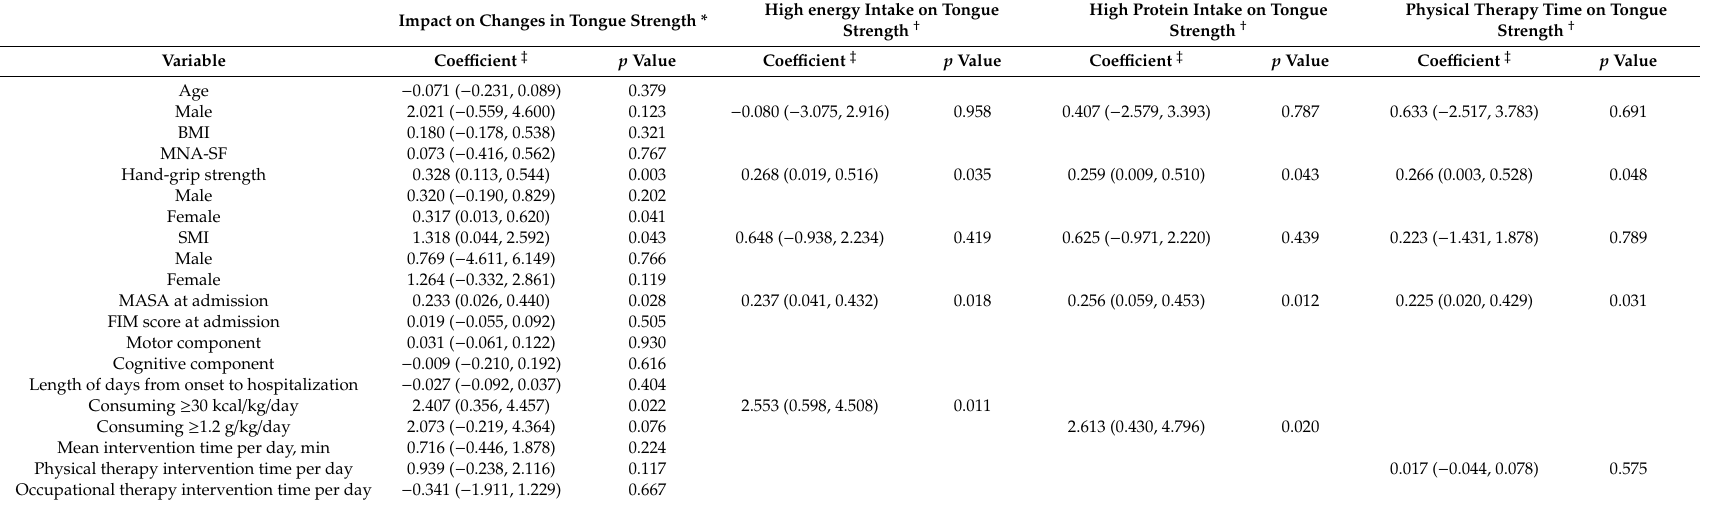
Table 4. Impact on tongue strength after